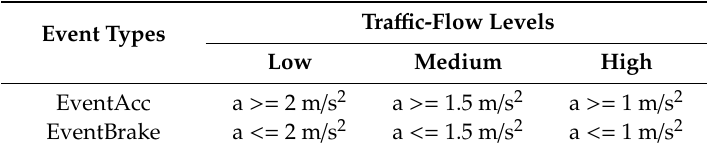
Table 1. Thresholds defined for sudden acceleration and sudden brake events depending on the tra ffi c-flow